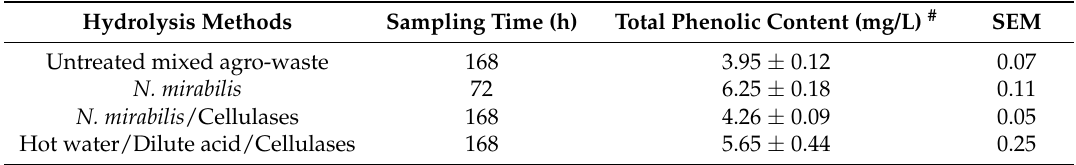
Total residual phenolic compounds in untreated, the N. mirabilis plant’s digestive fluids/cellulases and hot water/dilute acid/cellulases hydrolysed agro-waste samples (SEM: standard error of the